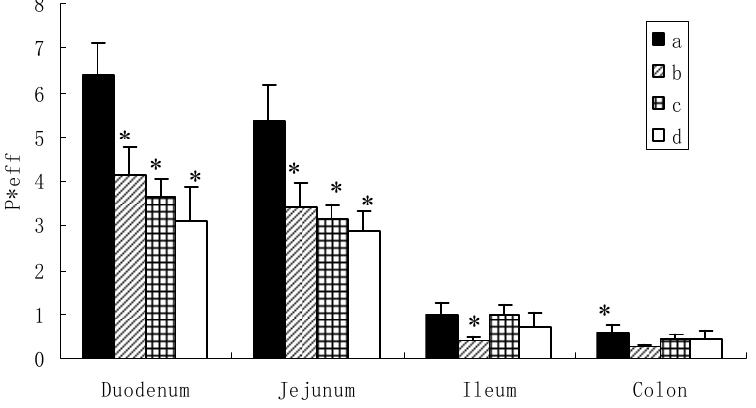
Figure 3. Comparison of permeability of icariin, epimedine A, epimedine B, epimedine C in different intestinal segements. a: icariin, b: epimedin A, c: epimedin B, d: epimedin C. Data are expressed as mean ± SD (n = 4). The statistically significant difference is shown by the asterisk symbol, icariin vs. epimedin A, epimedin B, epimedin C, * P <